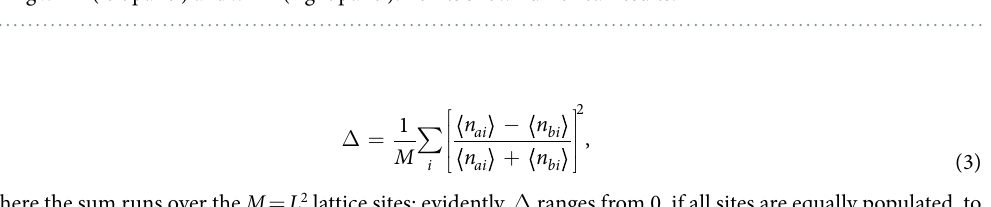
Figure 2. Parameter Δ as a function of temperature T / t and interspecies interactions U ab / t , at U / t = 10. Total filling n = 1 (left panel) and n = 2 (right panel). Points show numerical